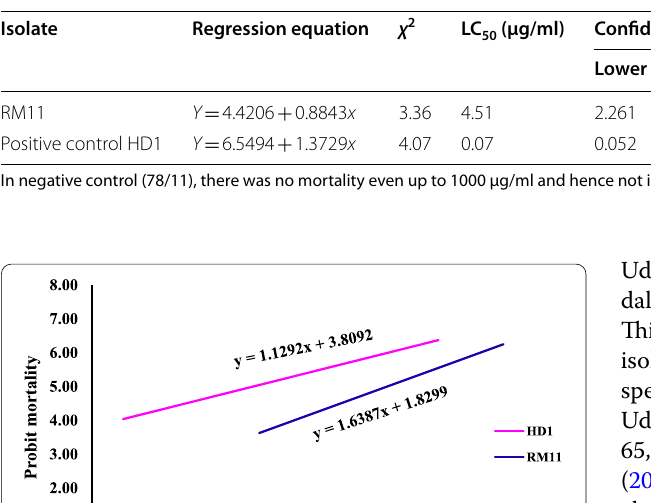
Table 3 Difference in toxicity of insolubilized and solubilized protein (RM11) to diamondback moth, Plutella xylostella larvae S.